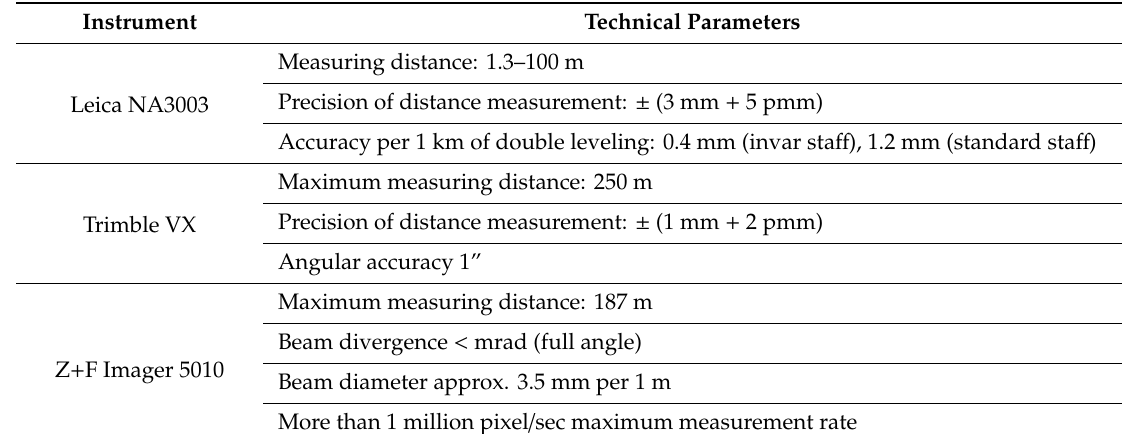
Table 4. The technical characteristics of measuring instruments (based on